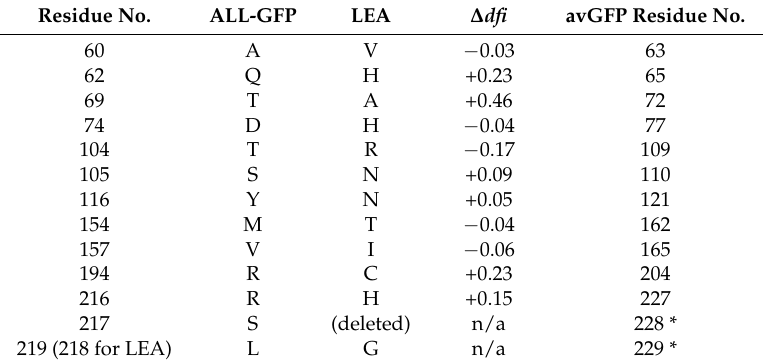
Table 1. Differences in amino acid residues between the common green ancestor ALL-GFP and least evolved ancestor (LEA) [21,22]. The changes in percent dfi values ( ∆ dfi , range − 0.5 to +0.5) and corresponding aequorea victoria green fluorescent protein (avGFP) residue numbers are also provided [13]. Residue No. ALL-GFP LEA ∆ dfi avGFP Residue No. 60 A V − 0.03 63 62 Q H +0.23 65 69 T A +0.46 72 74 D H − 0.04 77 104 T R − 0.17 109 105 S N +0.09 110 116 Y N +0.05 121 154 M T − 0.04 162 157 V I − 0.06 165 194 R C +0.23 204 216 R H +0.15 227 217 S (deleted) n/a 228 * 219 (218 for LEA) L G n/a 229